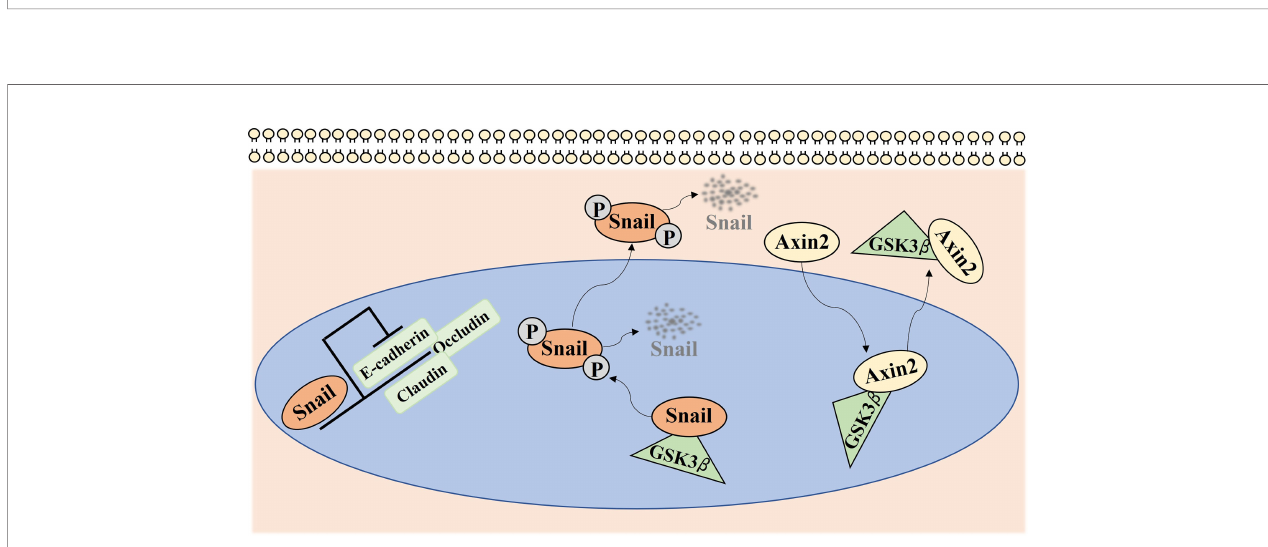
FIGURE 5 | Axin2 expression implicates cancer progression via regulation of Snail mediated epithelial-mesenchymal transition. Snail, as a transcriptional repressor of many genes, such as E-cadherin, Claudin, and Occludin, mediates epithelial-mesenchymal transition in various types of cancers. GSK-3 can bind to and phosphorylate Snail, resulting in the subsequent degradation of Snail. As a GSK-3 scaffolding protein, Axin2 mediates the nucleocytoplasmic shuttle for GSK-3, resulting in the stabilization of nuclear Snail.